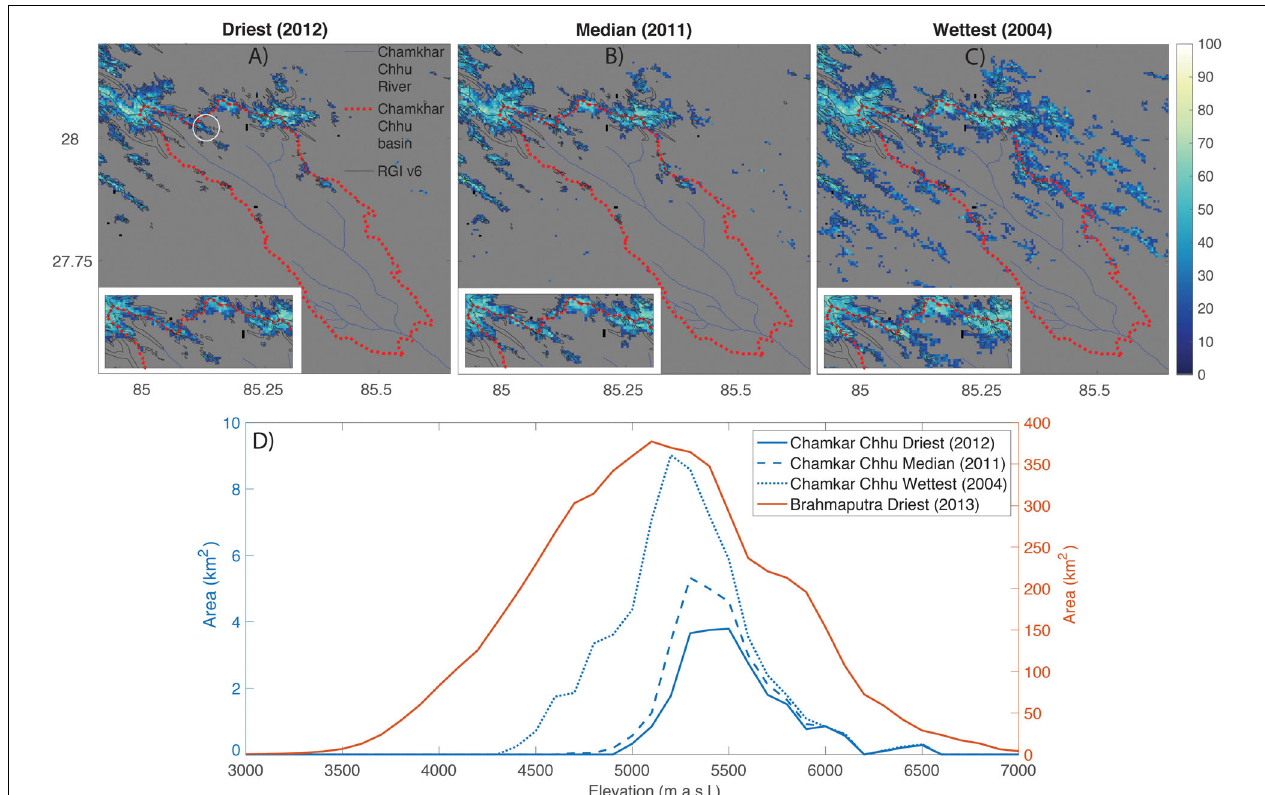
FIGURE 4 | Top row: Minimum snow and ice extent (SIE min ) in the Chamkhar Chhu basin (red dotted outline) for the driest (A) , median (B) , and wettest (C) years over the MODIS record. Colors represent the percent coverage per pixel of snow and ice at its minimum extent. The sampled Thanagang glacier is shown by white circle in (A) . Insets are close up of the most glaciated region of the basin. (D) SIE min hypsometries for the years shown in (A–C) . For comparison, SIE min hypsometry is also shown for the driest year over the MODIS record experienced by the larger Brahmaputra basin. Y-axis scales are color coded to the relevant